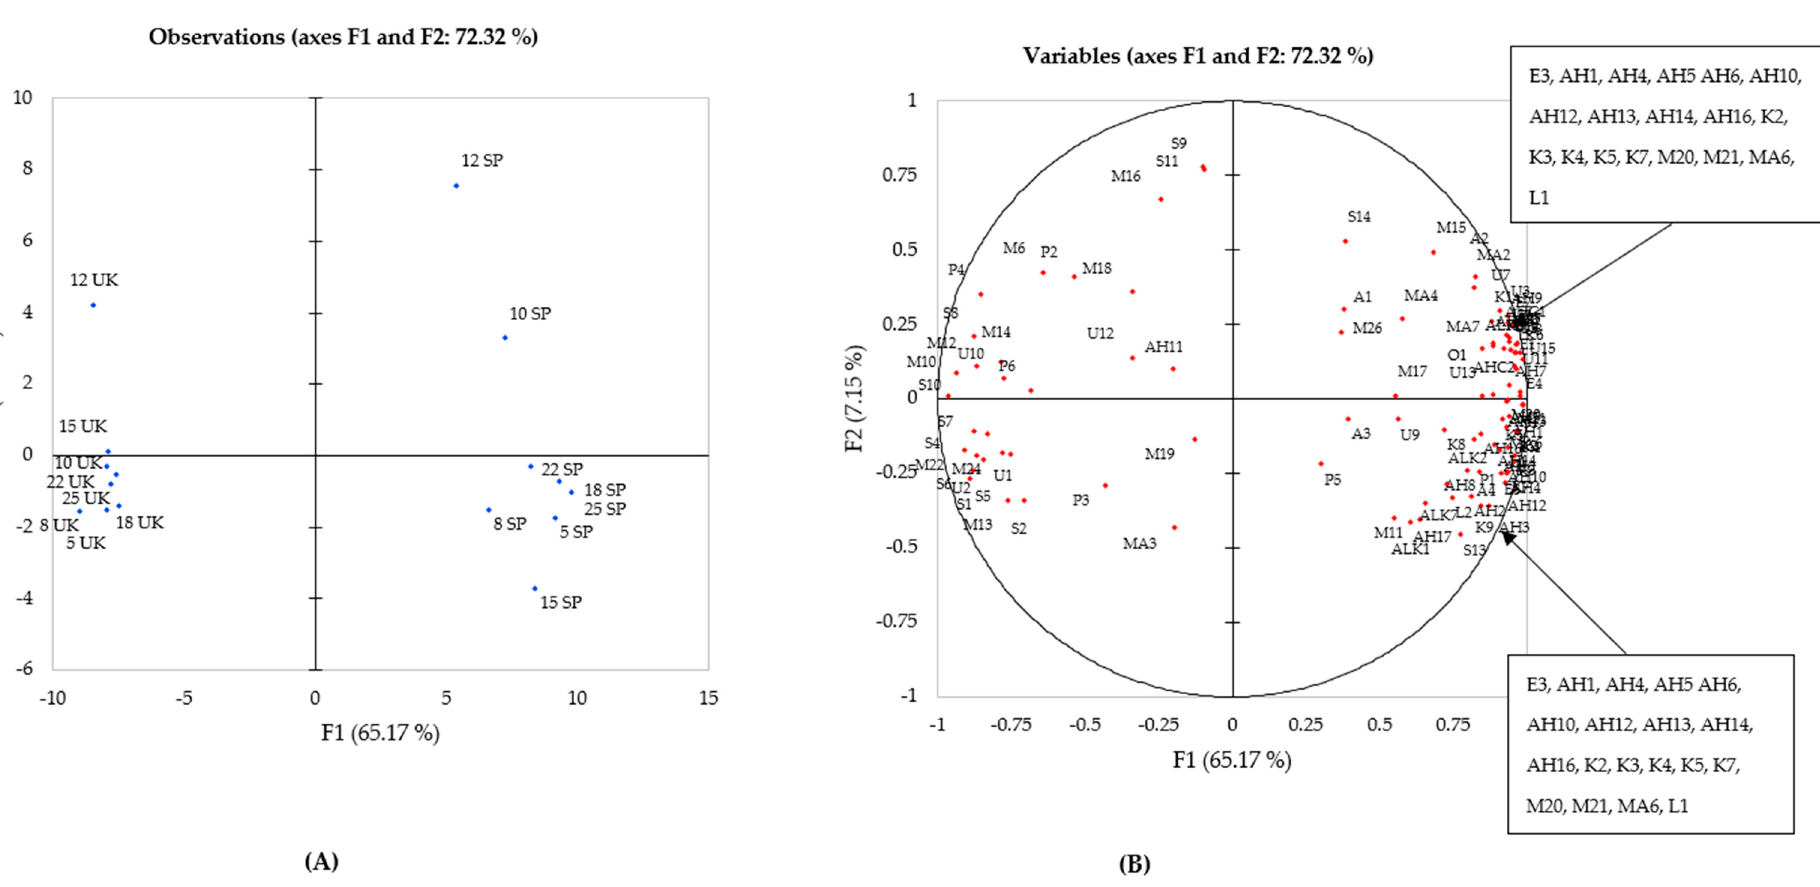
Figure 1. Principal component analysis of eight celery samples harvested in the UK in 2018 and Spain in 2019 showing correlations with volatile compounds. ( A ) Projection of the samples; ( B ) Distribution of variables.